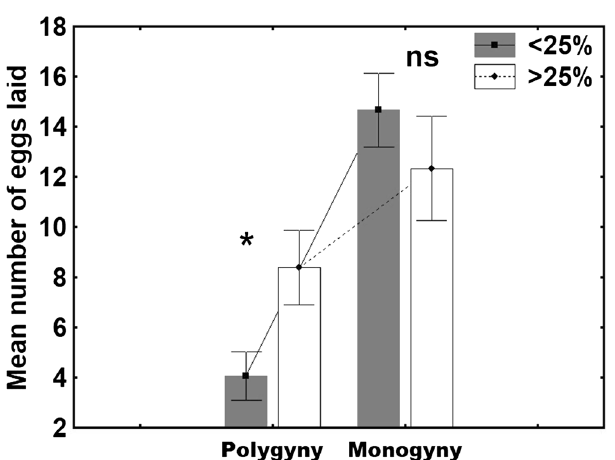
Figure 2. Mean number of eggs laid over a 24-h period (mean ± SE) by high-fecundity queens (> 25%; white bars) (n = 7) and low-fecundity queens (< 25%; grey bars) (n = 7) under polygynous and monogynous conditions. The asterisk denotes significant differences (* p < 0.05); ns: no significant